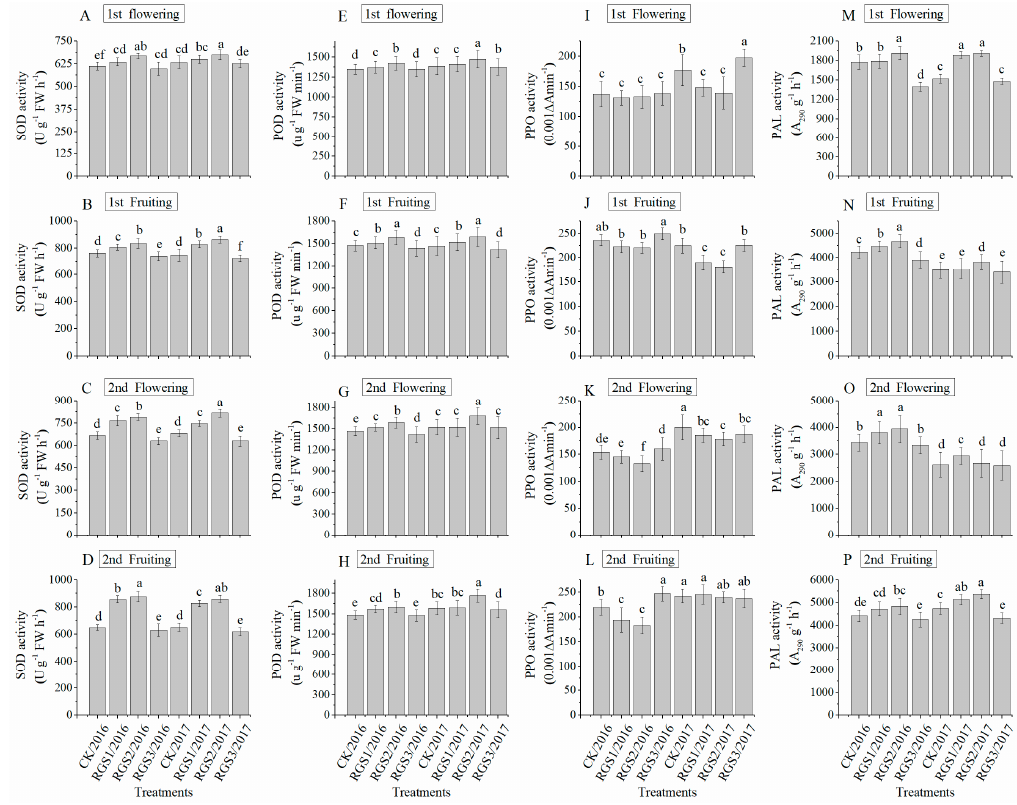
Figure 7. Effect of amendment with raw garlic stalk on superoxide dismutase (SOD) activity ( A ) 1st flowering, ( B ) 1st fruiting, ( C ) 2nd flowering and ( D ) 2nd fruiting. Peroxidase (POD) activity ( E ) 1st flowering, ( F ) 1st fruiting, ( G ) 2nd flowering and ( H ) 2nd fruiting. Phenylalanine ammonia–lyase (PAL) activity ( I ) 1st flowering, ( J ) 1st fruiting, ( K ) 2nd flowering and ( L ) 2nd fruiting. Polyphenol oxidase (PPO) activity ( M ) 1st flowering, ( N ) 1st fruiting, ( O ) 2nd flowering and ( P ) 2nd fruiting. The error bars represent standard error of the means ( n = 3). Different letters between treatments at different sampling stages show significant difference at p < 0.05 level (ANOVA and LSD).